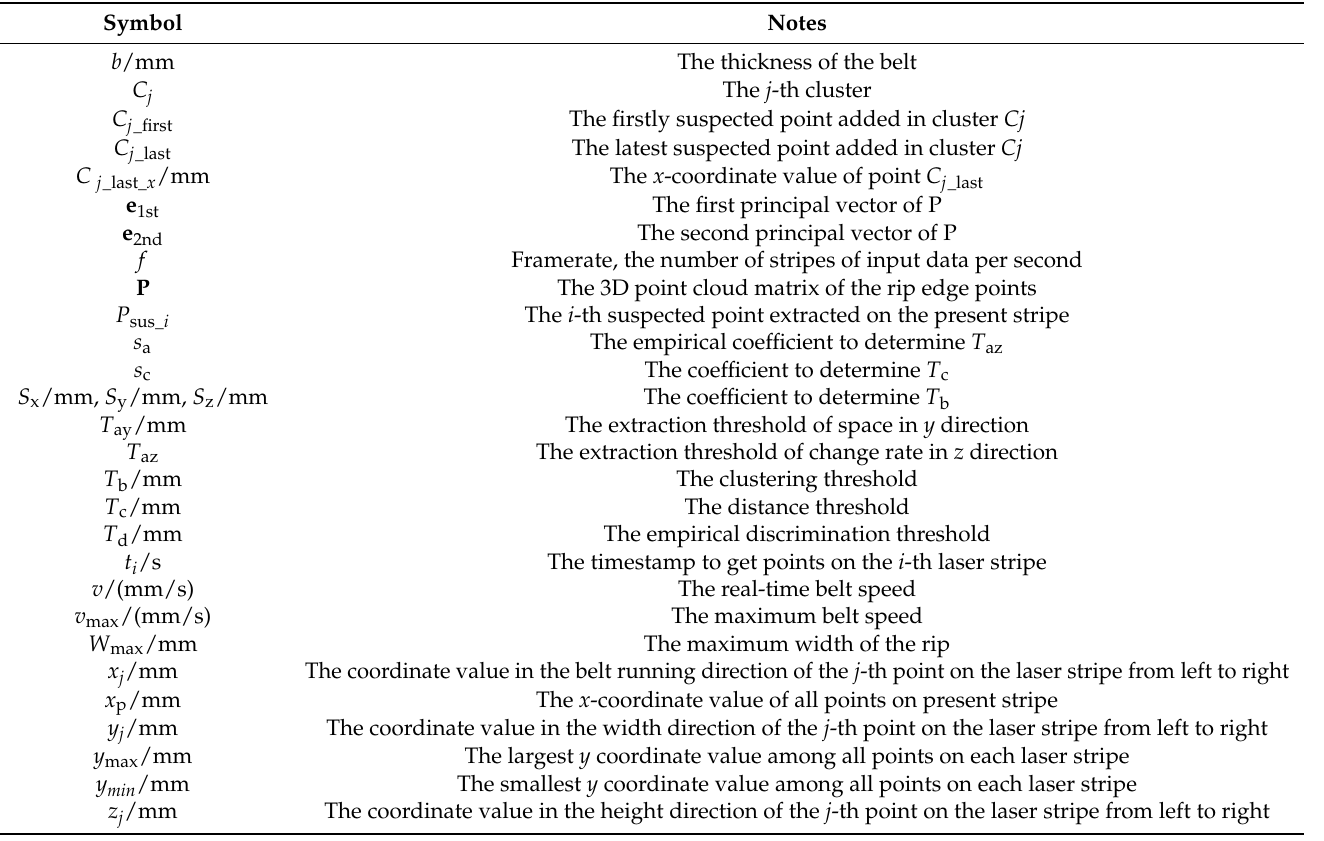
Table A1. List of symbols in this